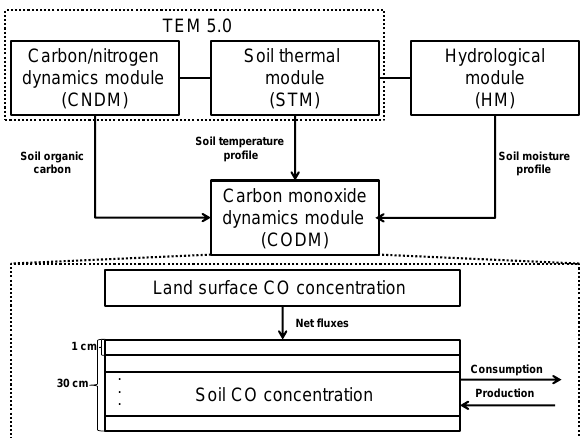
Figure 1. The model framework includes a carbon and nitrogen dy- namics module (CNDM), a soil thermal module (STM) from Ter- restrial Ecosystem Model (TEM) 5.0 (Zhuang et al., 2001, 2003), a hydrological module (HM) based on a land surface module (Bonan, 1996; Zhuang et al., 2004), and a carbon monoxide dynamics mod- ule (CODM). The detailed structure of CODM includes land surface CO concentration as the top boundary and 30 1cm thick layers (in total, 30cm) where consumption and production take